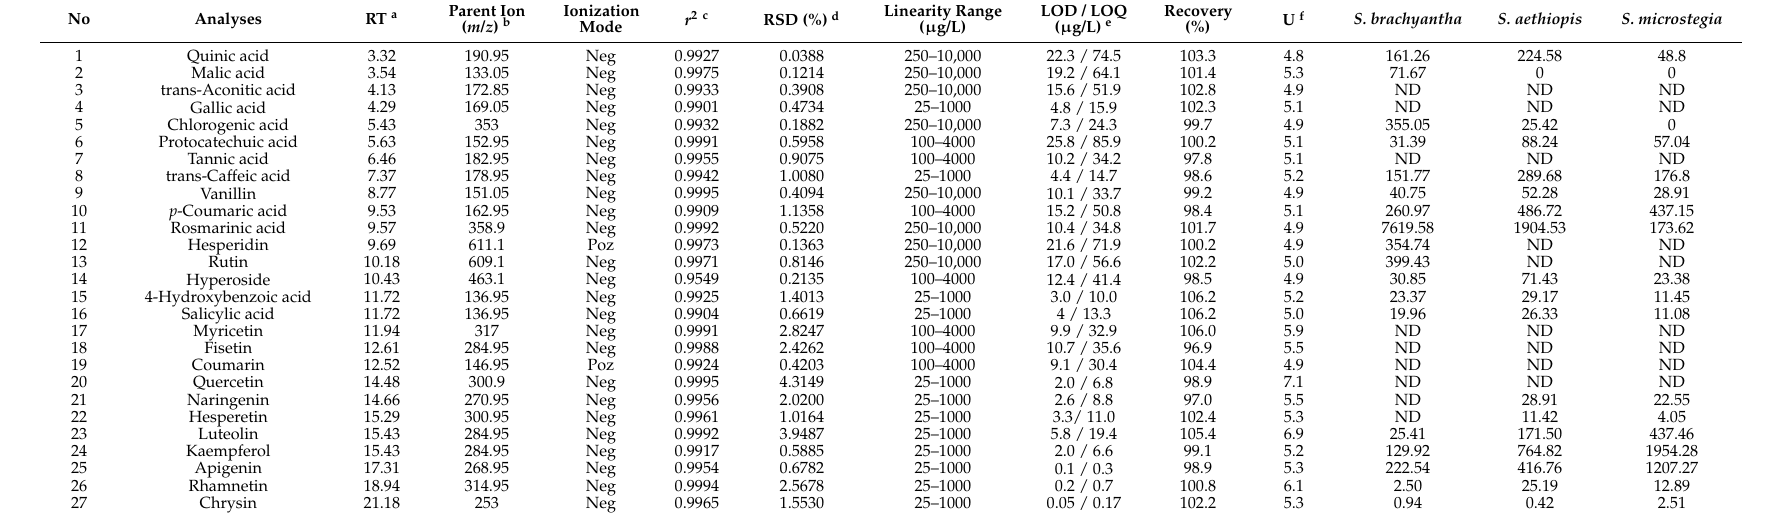
Table 1. LC-MS/MS parameters of selected compounds and amount of three Salvia species ( µ